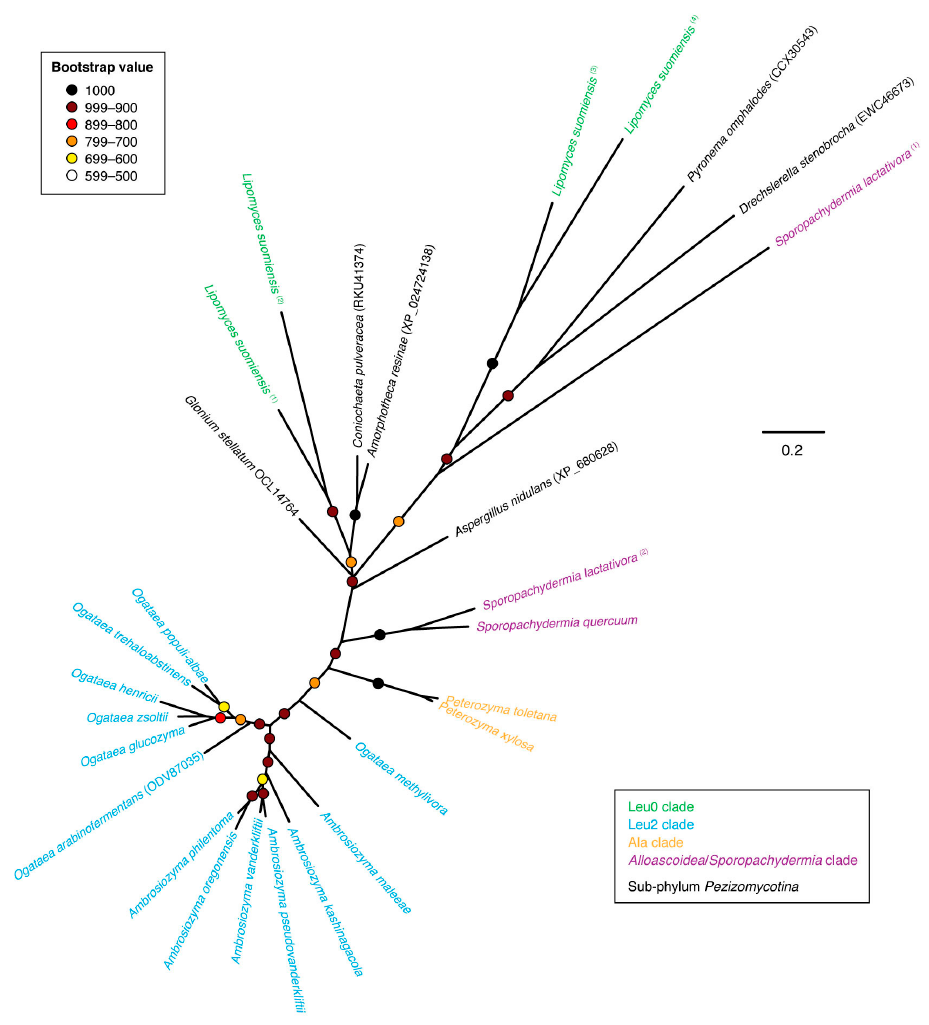
Figure 9. Unrooted tree of CYP5078 gene products in representative species of sub-phylum Saccharomycotina as well as selected non- Saccharomycotina species. Individual species are color-coded with respect to clade [24]. The analysis was based on 403 aligned amino acid positions of the corresponding proteins. Colored circles represent branch support with the color indicating the proportion of retained nodes among 1000 bootstrap replicates. Branches lacking circles indicate branch support less than 500. Accession numbers for individual protein sequences are displayed